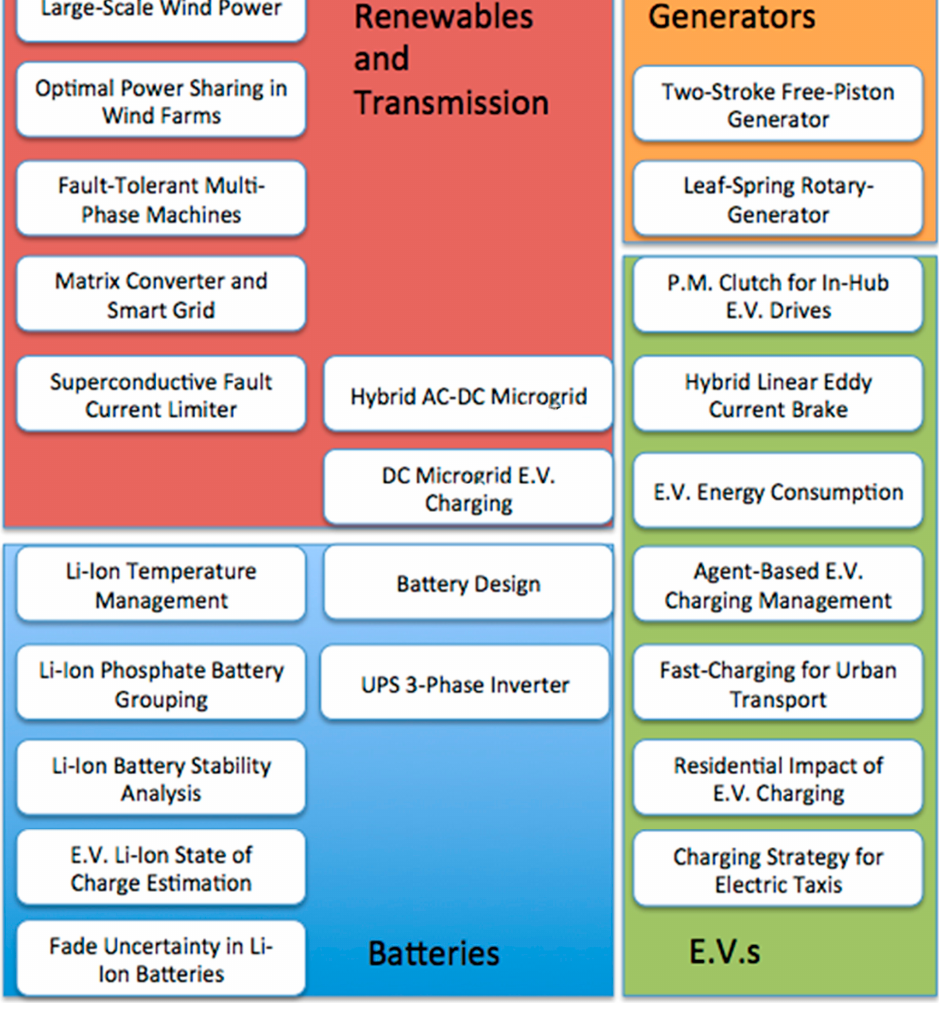
Figure 1. The broad spectrum of published submissions.